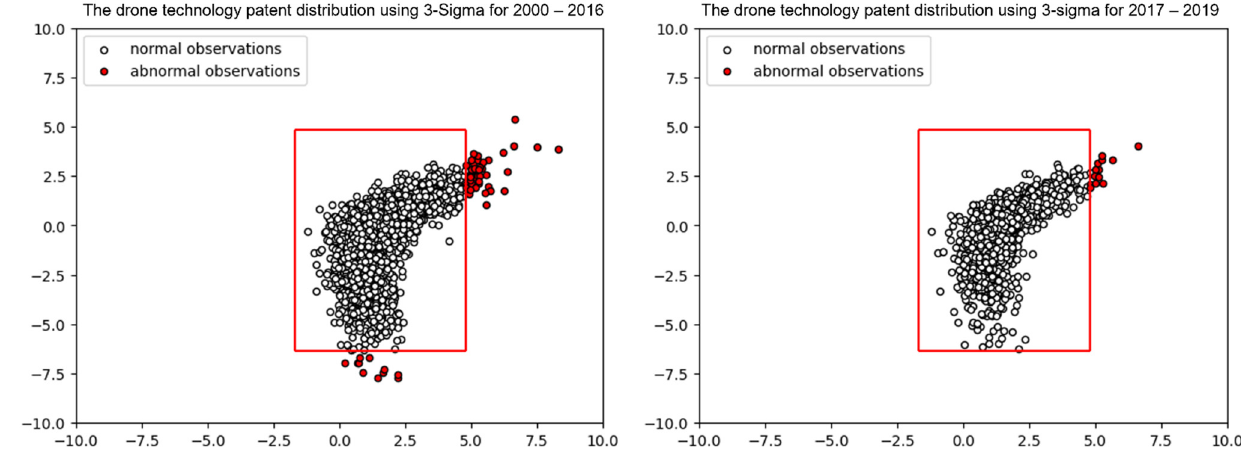
Figure 7. The result of document embedding (three-sigma rule).